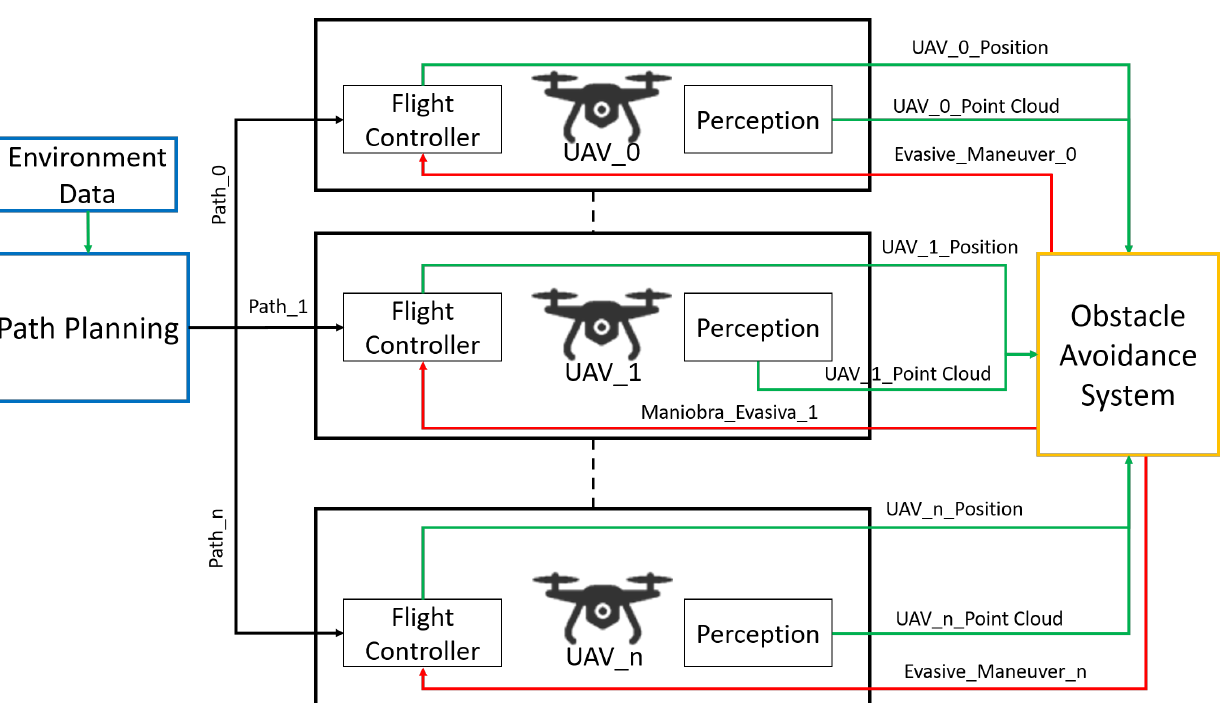
Figure 1. General scheme of the proposed autonomous Unmanned Aerial Vehicle (UAV)